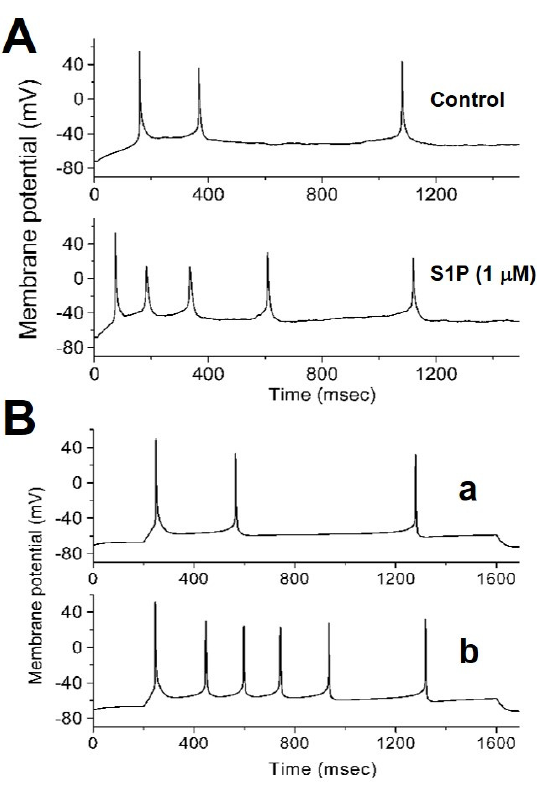
Figure 5. Effects of S1P on action potentials (APs) and simulated AP of a modeling chromaffin cell. ( A ) Current-clamp conditions were performed with the current injection of 2 nA applied to the cell with a duration of 1.6 s. The cells were bathed in a normal Tyrode solution with 1.8 mM CaCl 2 . Potential traces were recorded in the control and exposure to S1P (1 µ M). ( B ) The simulated APs were generated from a cell model which mimics the electrical behavior of chromaffin cell. A current injection at the 4.6 nA with 1.4 s duration was applied. S1P (1 µ M) was mimicked I K(Ca) by the maximal conductance (g K(Ca) ) from 0.64 (a) to 0.32 nS (b).